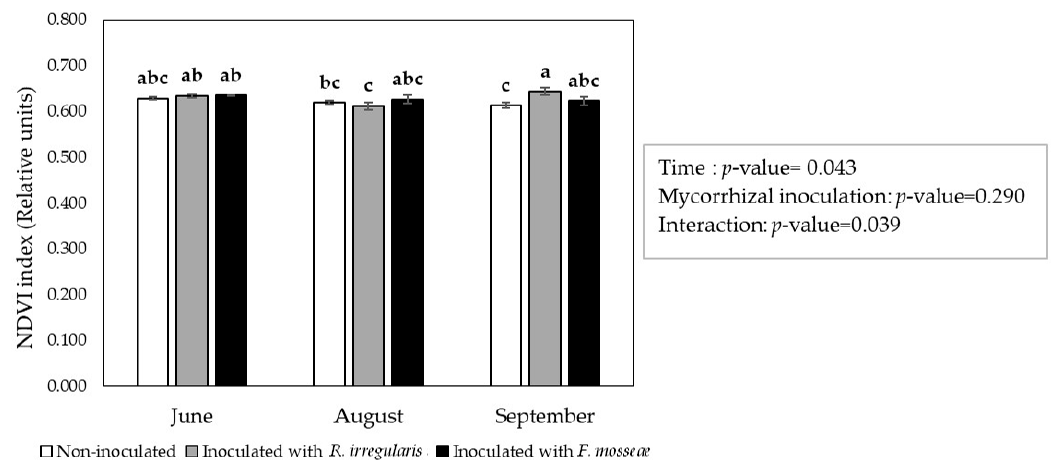
Figure 2. Normalized di ff erence vegetation index in ‘Touriga Nacional’ variety vine plants grafted onto 1103 Paulsen rootstock measured along the first growing season. Bars indicate the average value ( n = 5) ± standard error. Di ff erent letters indicate significant di ff erences in group means according to pairwise multiple comparisons conducted using the simulation method of Edwards and Berry [70]. Values within the box indicate the p- value for the significance of the main factors and their interaction. Significant e ff ect, p -value <